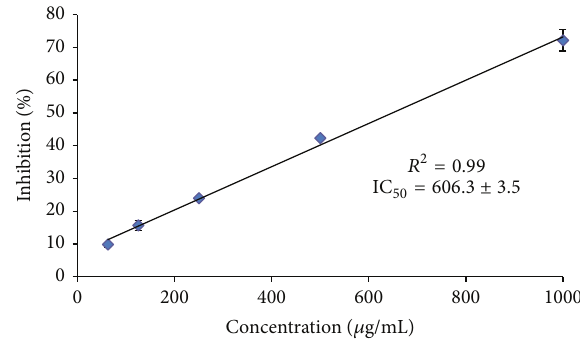
Figure 2: Colorimetric assessment of antioxidant capacity using in the DPPH assay. Values represent mean ± standard deviation of the mean of replicate readings ( 𝑛 = 3 ). The IC 50 values denote the concentration of the sample, which is required to scavenge 50% of free